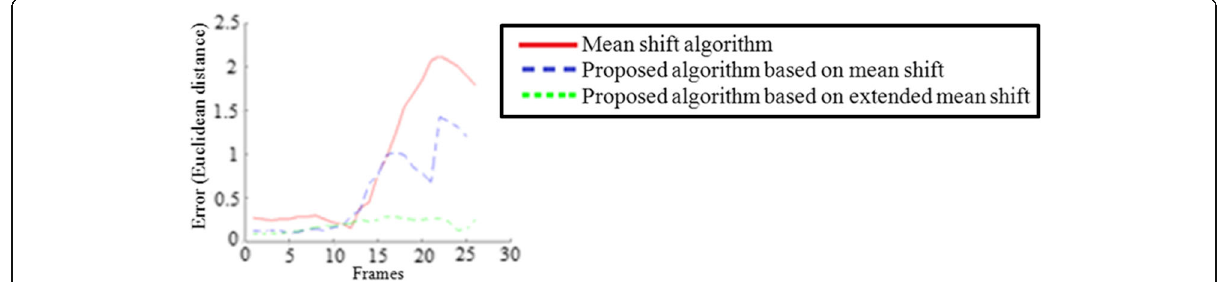
Fig. 20 Comparison of methods based on tracking error in object deformation for image sequences of Fig. 19